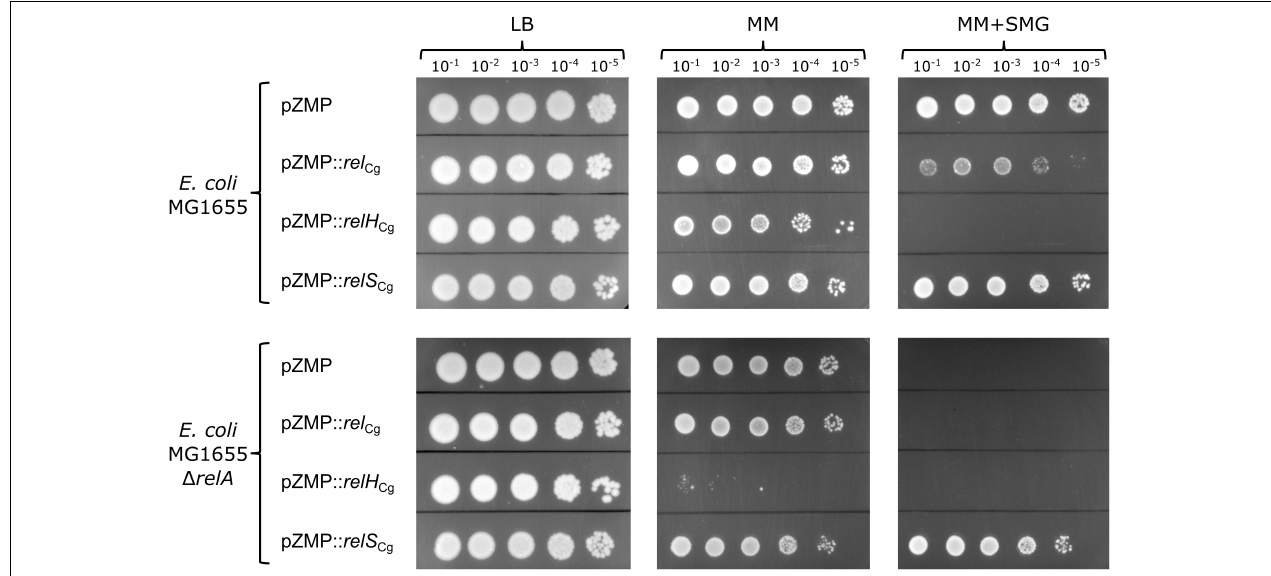
FIGURE 3 | Growth characterization of E. coli MG1655 and E. coli MG1655 (cid:49) relA , each heterologously expressing the C. glutamicum genes rel Cg , relH Cg or relS Cg , on different solid medium plates. The empty vector pZMP was used as control. All strains were cultivated using initial OD 600 values of 0.05 in LB-medium for 3 h. The cells were washed and serially diluted in PBS-buffer. 5 µ L aliquots of every strain and dilution stage were spotted on LB medium plates (LB), minimal medium plates (MM) and minimal medium plates containing each 1 mM L -serine, L -methionine, and L -glycine (MM+SMG). All solid media plates contained 50 µ g mL − 1 kanamycin and 4 g L − 1 glycerol was used as C source for all minimal medium plates. Incubation was carried out at 37 ◦ C for 24 h in the case of LB solid medium and 48 h for MM and MM+SMG